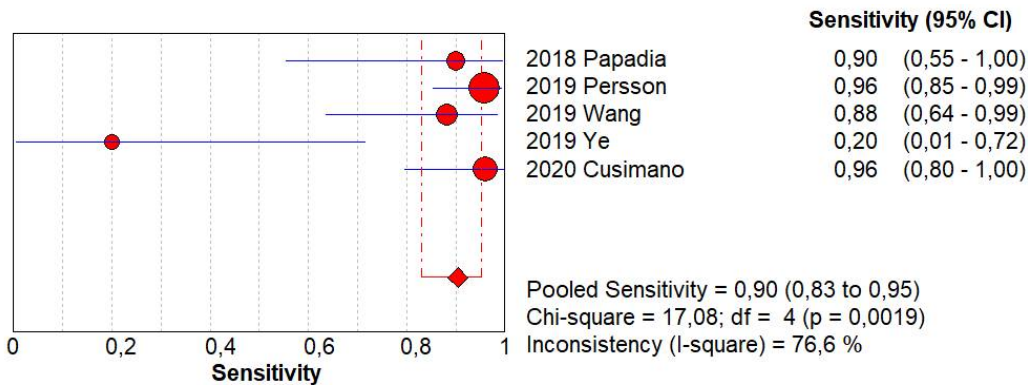
Figure 1. Forest plots of individual studies and pooled sensitivity of sentinel lymph node biopsy in detecting endometrial carcinoma metastasis.